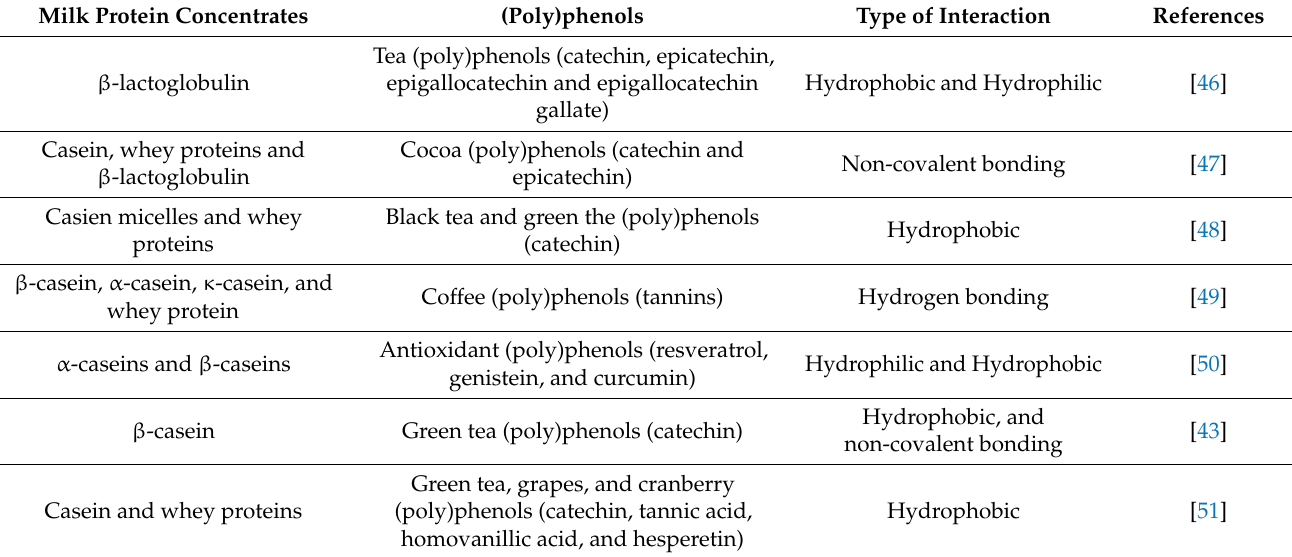
Figure 7. Different types of intermolecular and intramolecular interaction between protein molecules and plant-based (poly)phenolic components. Herein, (a) disulfide bonds function to stabilize the quaternary structure of milk proteins and (poly)phenols, (b) hydrogen bonds provide most of the directional interaction that underpins milk proteins folding with (poly)phenols, and (c) ionic bonds are potent electrostatic attractions; therefore, they form as atoms of amino acids bearing opposite electrical charges, (d) hydrophobic interactions allow the milk protein surface to decrease and also reduce the undesirable interaction between (poly)phenols. Table 1. Milk protein concentrates and their interactions with (poly)phenols.